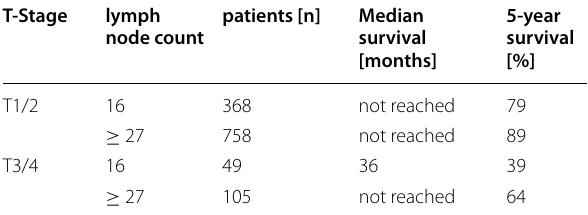
Table 1 Relative survival in nodal negative patients with different lymph node counts T-Stage